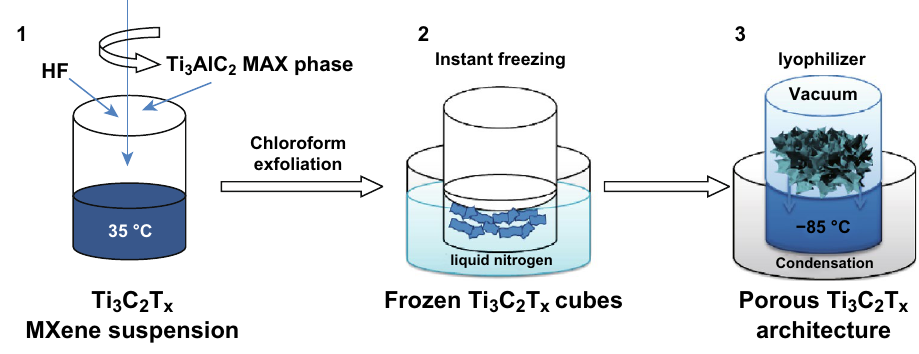
Fig. 12 Synthetic procedure for the porous Ti 3 C 2 T x architecture. Reprinted with permission from Ref. [62] Copyright © (2018) Elsevier Inc